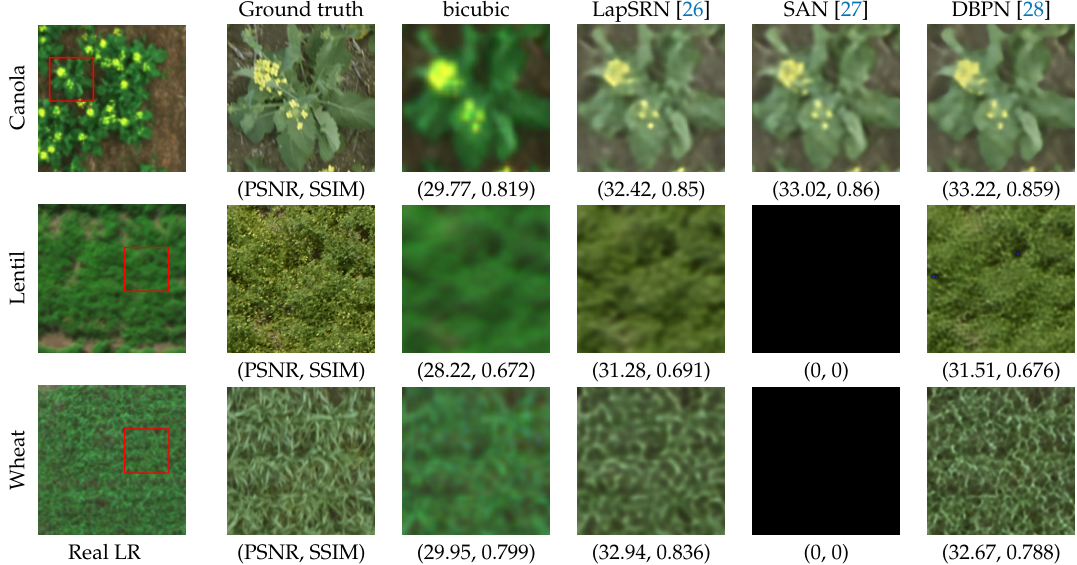
Figure 6. Example test images from the synthetic-real experiment for canola, lentil and wheat datasets (top/middle/bottom rows). Ground truth HR images (left) are shown with the cropped region denoted by a red box. PSNR and SSIM values are listed below each image. Black images for SAN denote that the model failed to converge when trained on the lentil and wheat datasets.